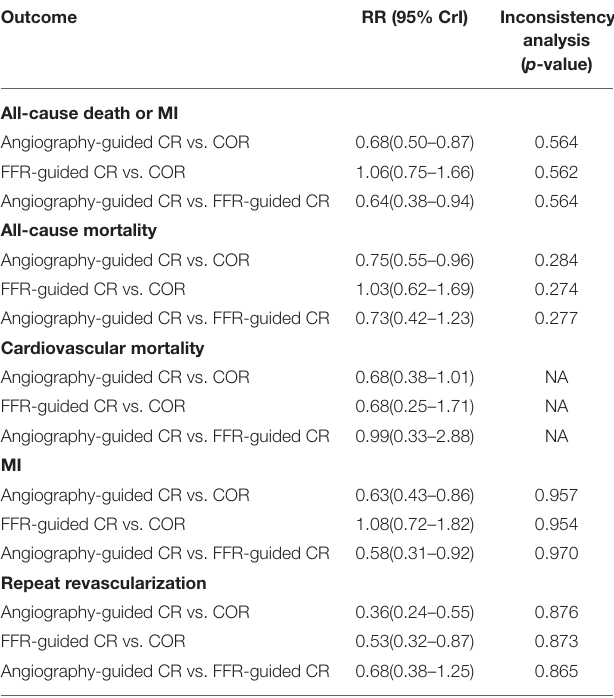
TABLE 2 | The results of network